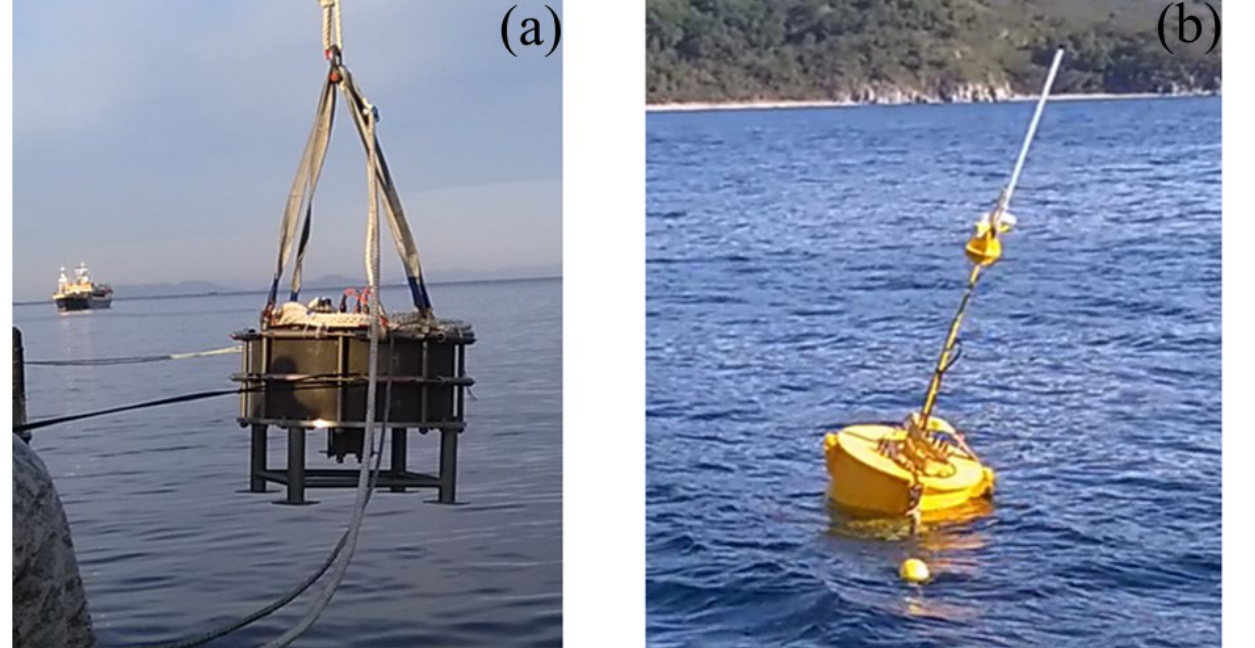
Figure 3. Autonomous broadband hydroacoustic source ( a ) and its surface buoy with power supply and radio transceiver ( b ).